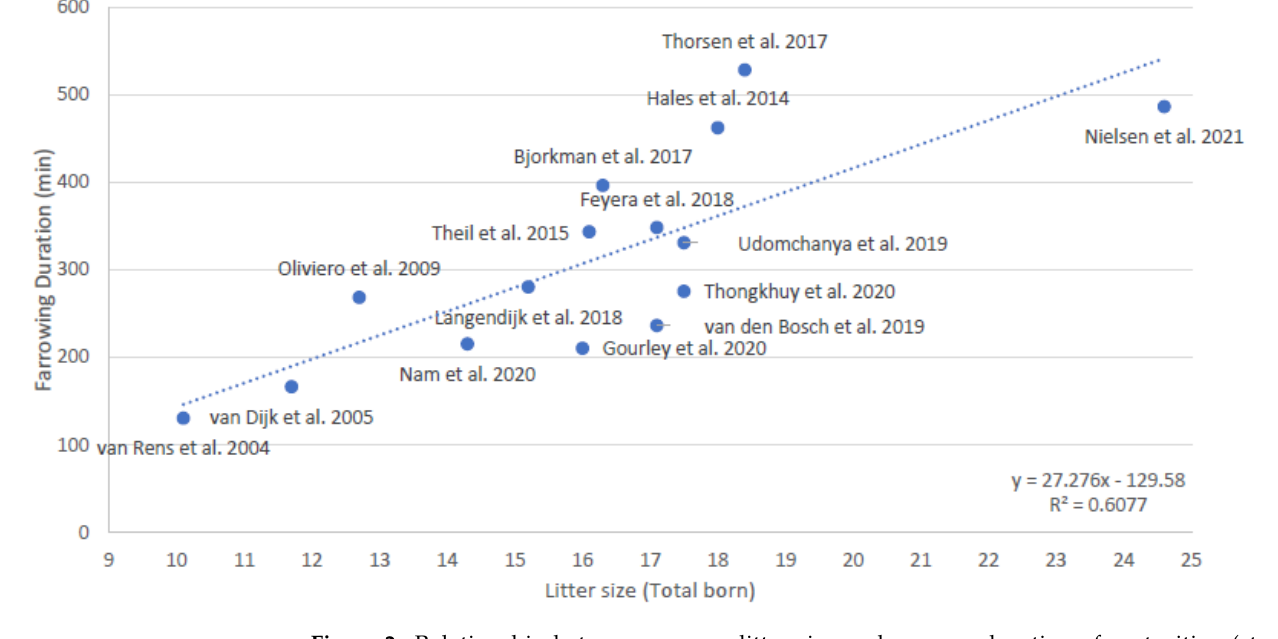
Figure 2. Relationship between average litter size and average duration of parturition (stage 2, expulsion of piglets) based on averages of 15 studies conducted over the last 18 years [12,14,17,46,47,57 – 66] .